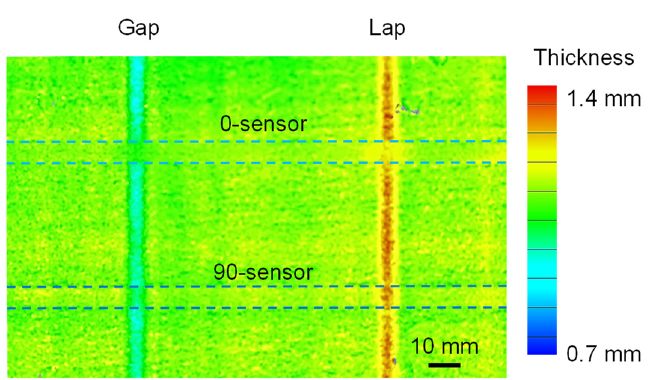
Figure 13. Thickness distribution around gap/lap.